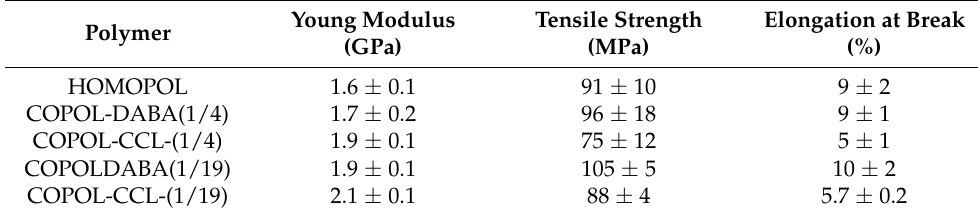
Table 6. Mechanical properties of polymers.